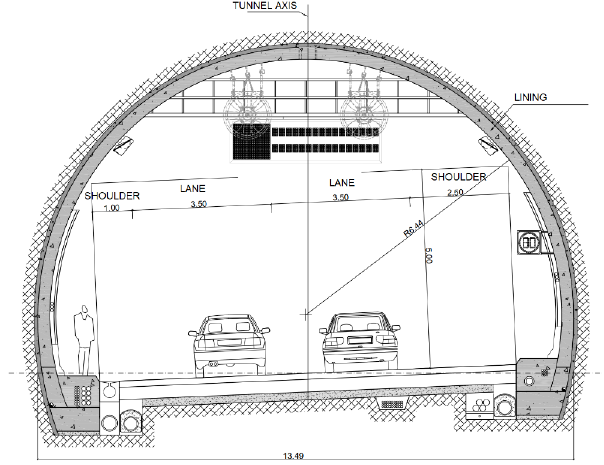
Figure 3. Functional section of the Arnotegi tunnel (5 m vertical clearance). Table 1. Main geometrical characteristics in Arnotegi tunnel.